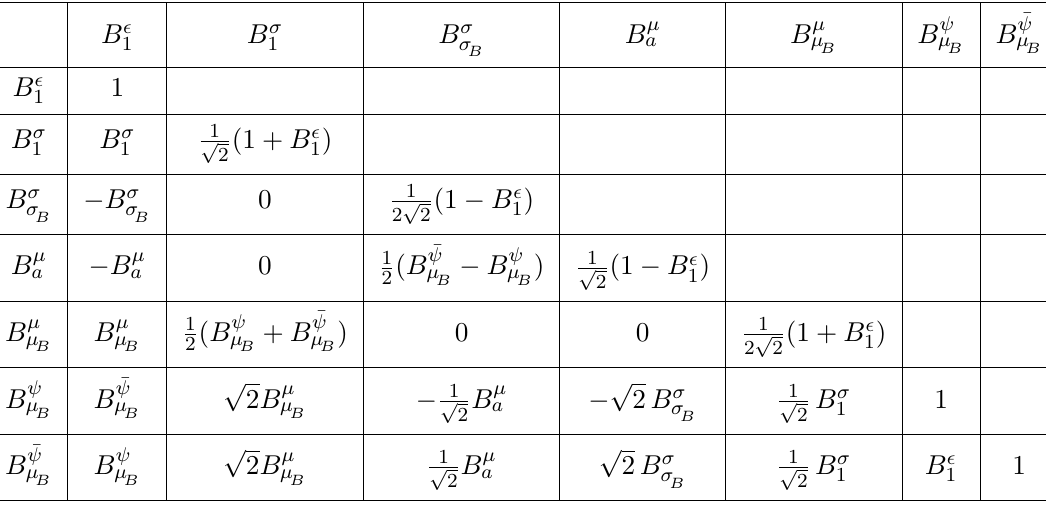
Table 4 . The sewing constraints from (3.7), rewritten in the from B (cid:11) stated explicitly as a multiplication table; the sewing constraints for the standard Ising model are in the top left 3 (cid:2) 3